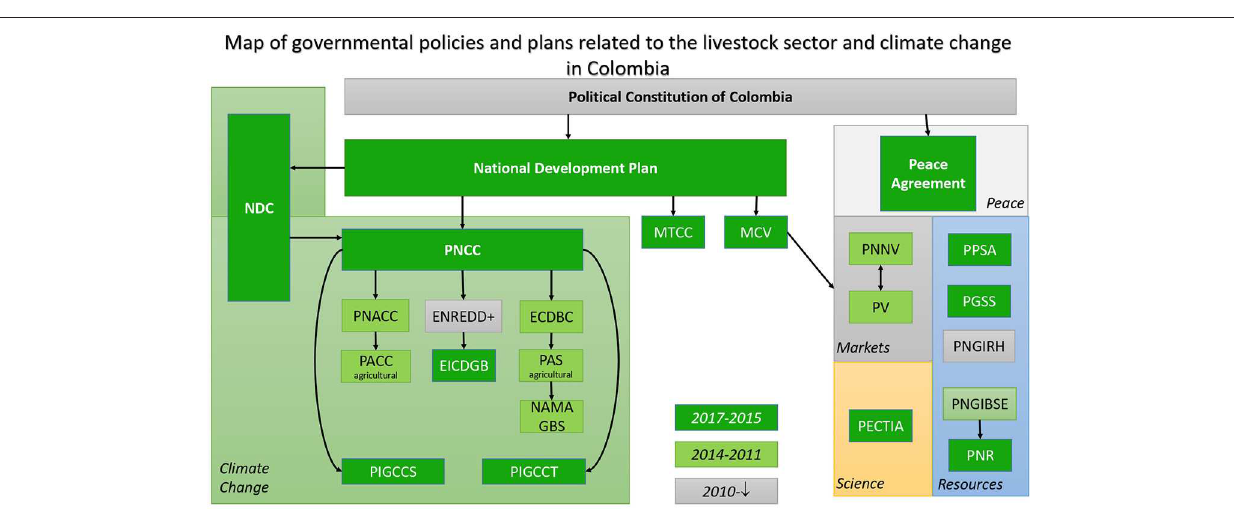
It is focused on the implementation of silvopastoral systems, but at present has no financing, and there is no involvement by the private